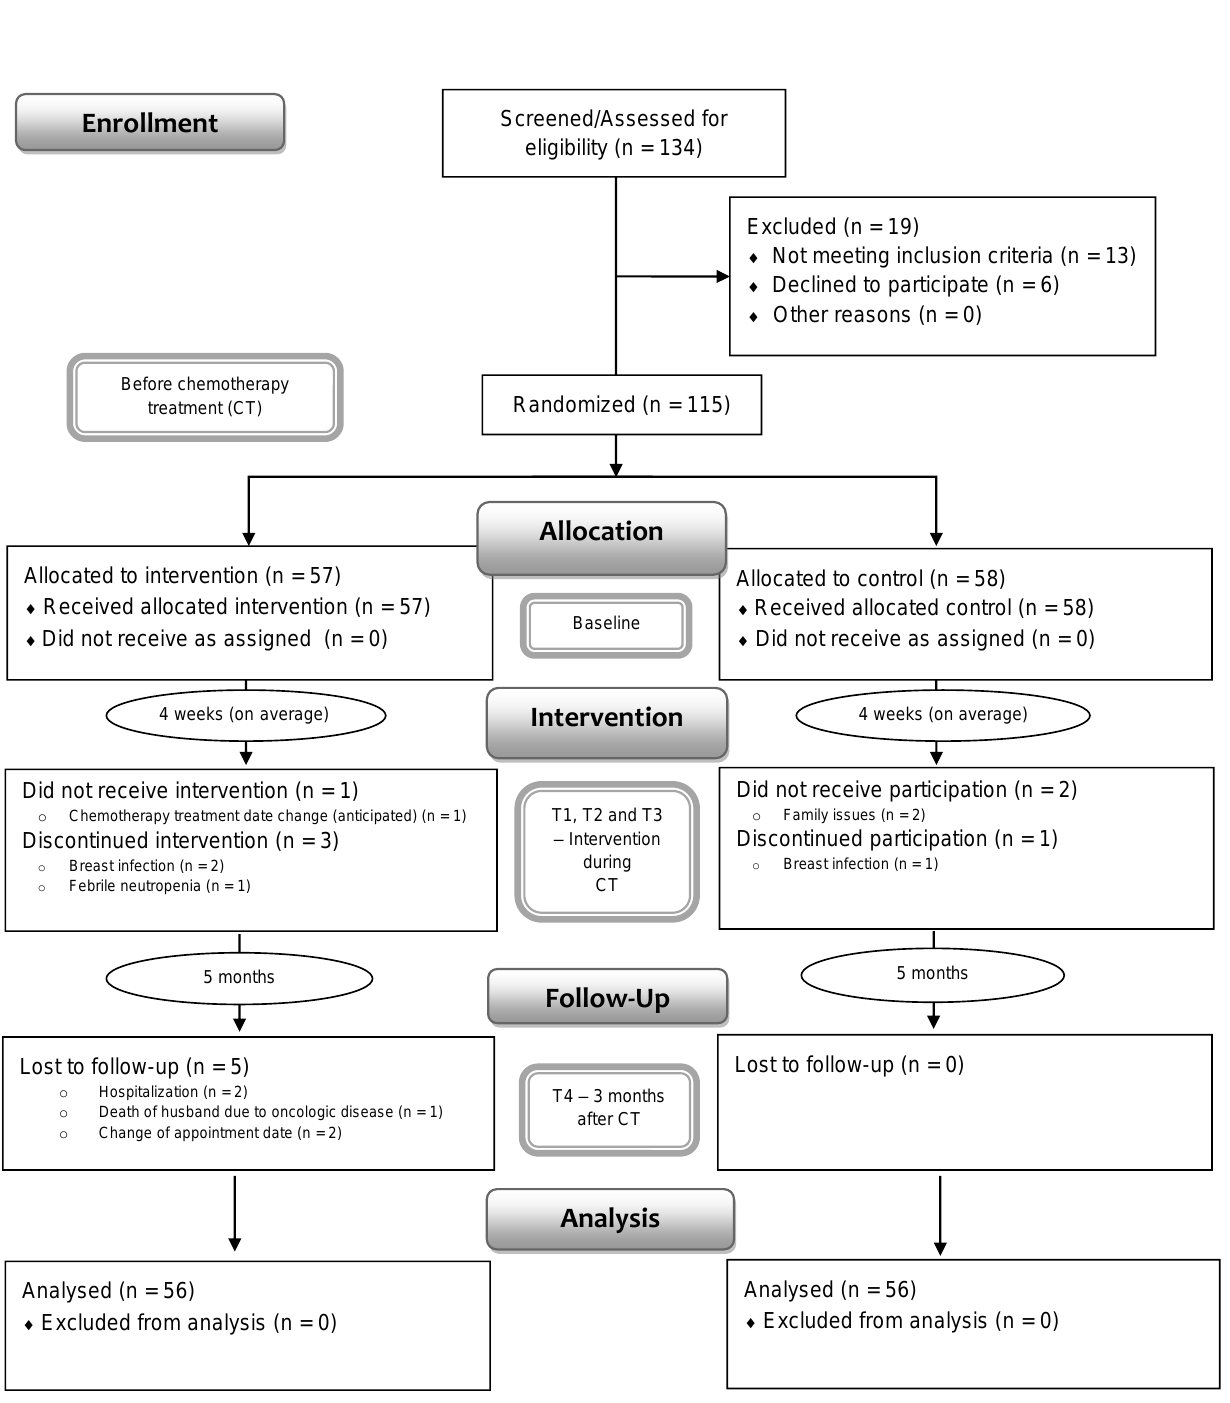
Figure 1. CONSORT flowchart of the present